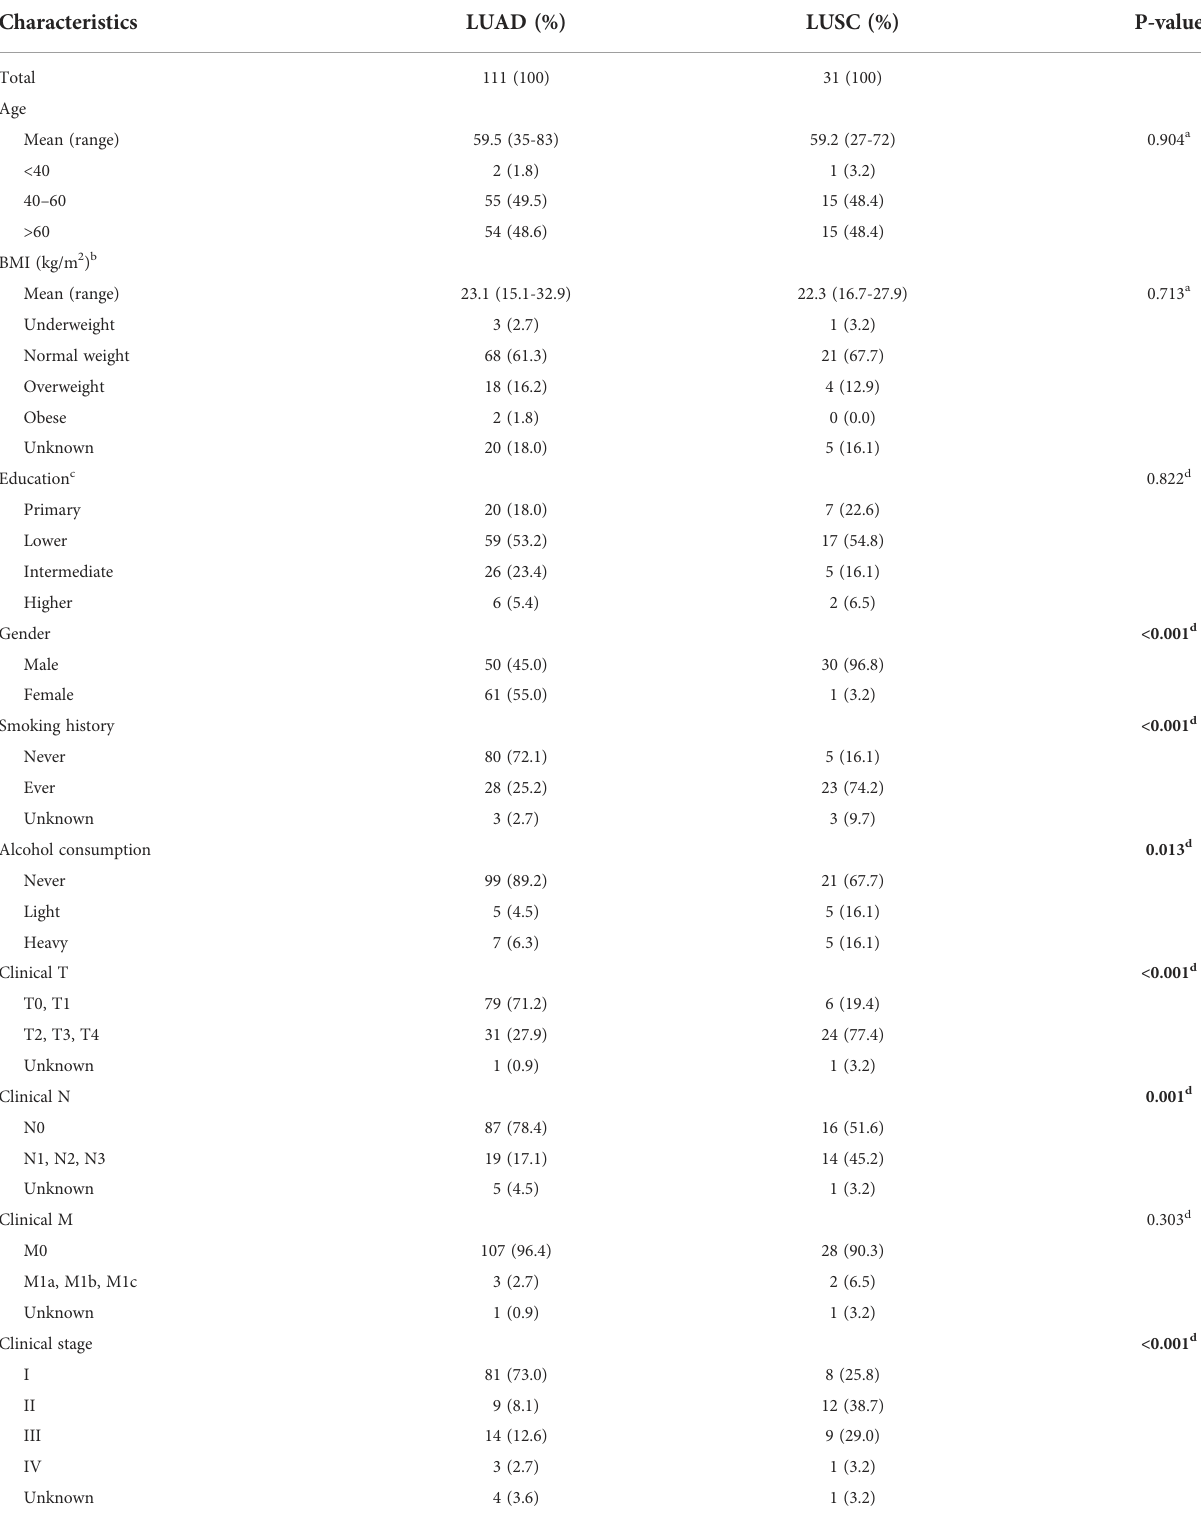
TABLE 1 Demographic and tumour characteristics of